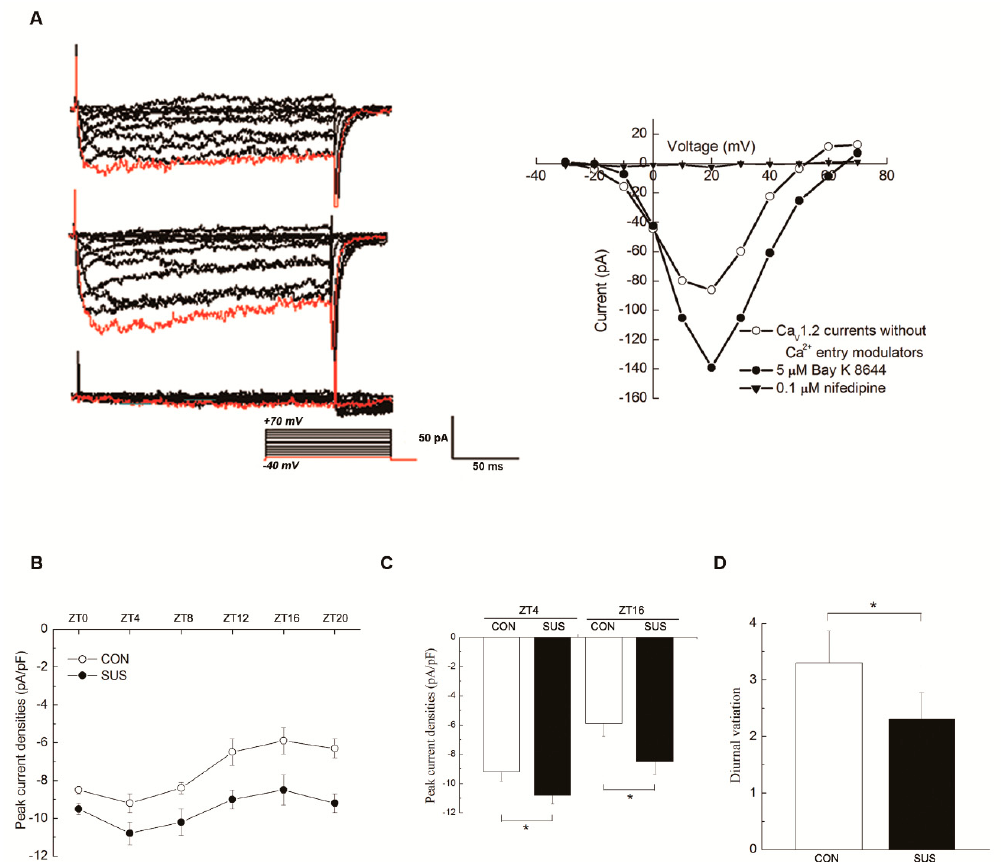
Figure 2. Circadian rhythm of Ca V 1.2 activities in cerebrovascular SMCs isolated from CON and SUS rats at six di ff erent time points. ( A ) The representative families of inward currents recorded in cerebrovascular SMCs without Ca 2 + entry modulators, in the presence of agonist Bay K 8644 or antagonist nifedipine in the bath solution. ( B ) The peak current densities of Ca V 1.2 channel at + 20 mV showed a circadian oscillation with the peak activities at ZT4 (the subjective light) and the trough activities at ZT16 (the subjective dark) in CON rats. ( C ) The peak current densities of Ca V 1.2 markedly increased at both ZT4 and ZT16 in SUS rats as compared with that in CON rats. ( D ) The diurnal variation in Ca V 1.2 activities (the difference value between ZT4 and ZT16 level) significantly decreased in SUS rats as compared with that in CON rats. Data are presented as box plots and 5th and 95th percentiles. n = 10, t -test or two-way ANOVA and Tukey’s multiple comparisons test, * p < 0.05, CON: 28-day simultaneous control rats; SUS: 28-day tail-suspended rats.